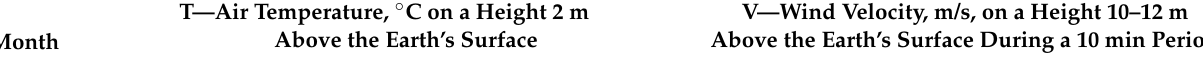
Table 1. Main climatic characteristics for winter period in the Murmansk metropolitan area. (source: Construction Climatology, SP